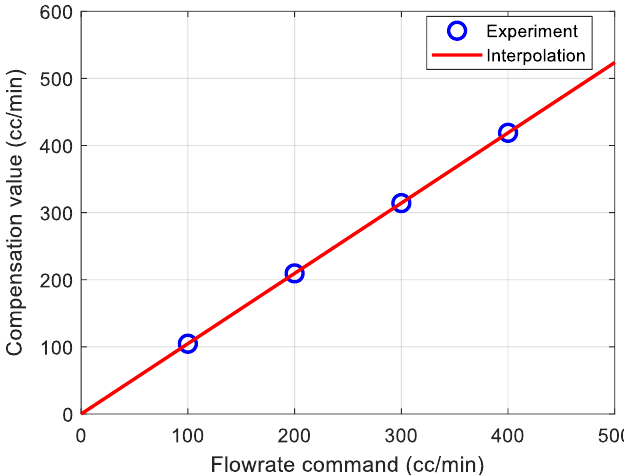
Figure 9. Flowrate command dependent compensation value.